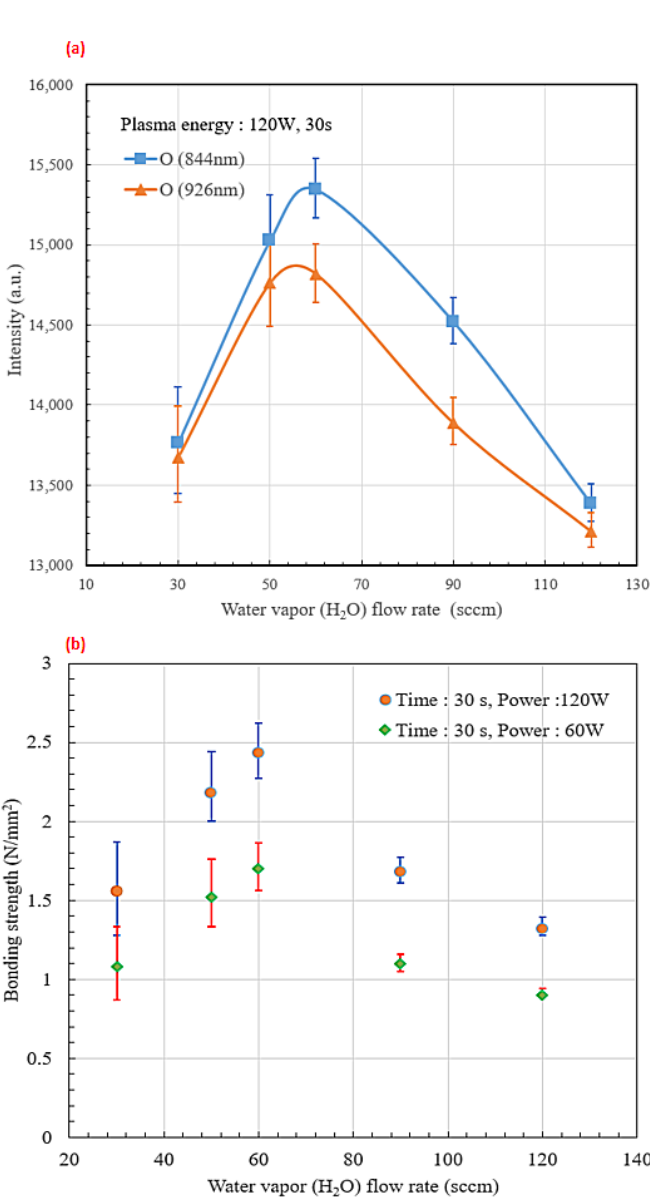
Figure 6. ( a ) Intensity of the O bonds (844 nm and 926 nm) emission lines as a function of gas flow rate. ( b ) Bonding strength with standard deviation of the heterogeneous bond strengths of PMMA/silicon substrates after H 2 O plasma treatment at gas flow rates of 30, 50, 60, 90 and 120 sccm, with plasma powers of 60 and 120 W.